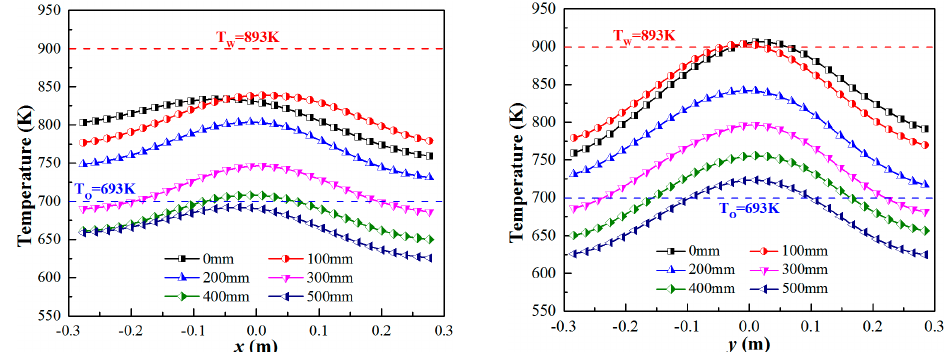
Figure 8. Temperature profile of the line with different extension distances (the lines are defined as shown in Figure 1).